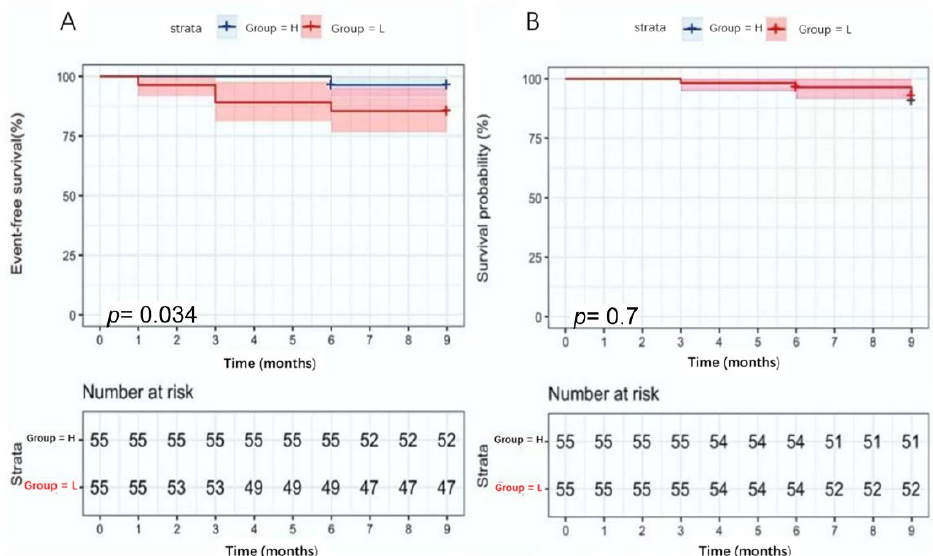
Figure 5. Kaplan–Meier curves analyze the event-free survival of the high-level and the low-level CTRP9 groups. According to the CTRP9 cutoff value, patients were divided into low-level and high-level CTRP9 groups. ( A ) The Kaplan–Meier curve analysis of the two groups of patients without major endpoint events; the high-level CTRP9 group had the worse outcome ( p = 0.034). ( B ) The Kaplan–Meier curve analysis of the two groups of patients with no secondary endpoint events showed no difference between the two groups. H, high-level CTRP9 group; L, low-level CTRP9 group.